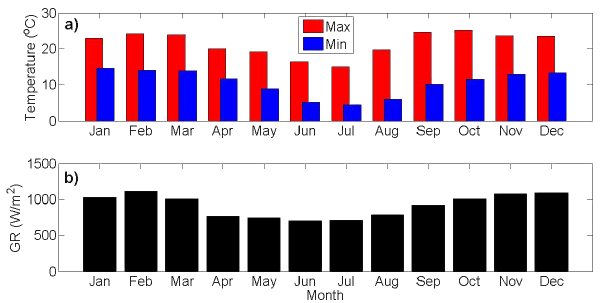
Fig. 2. Measured average temperatures (a) and daily maximum global radiation intensity (b) at Elandsfontein during 2010. In (a) the red bars indicate daily average maximum and blue bars the daily average minimum temperature. The values were calculated from 15min